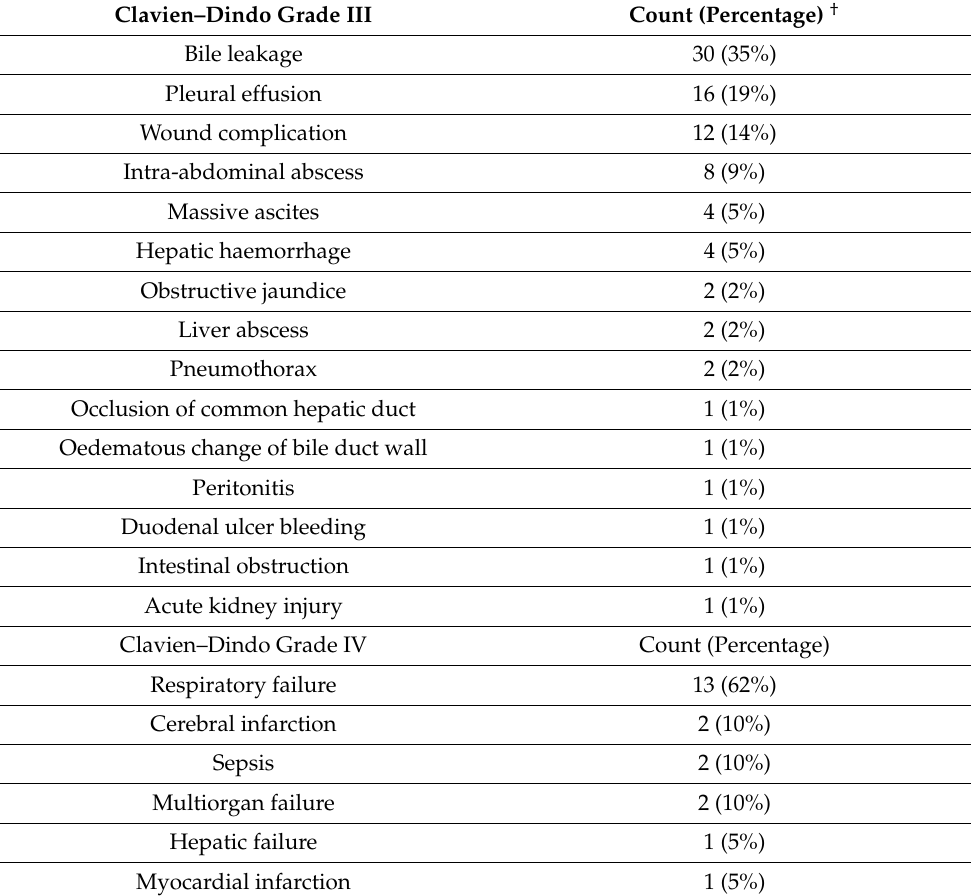
Table 2. Clavien–Dindo grade III and IV complications within 30 days after liver